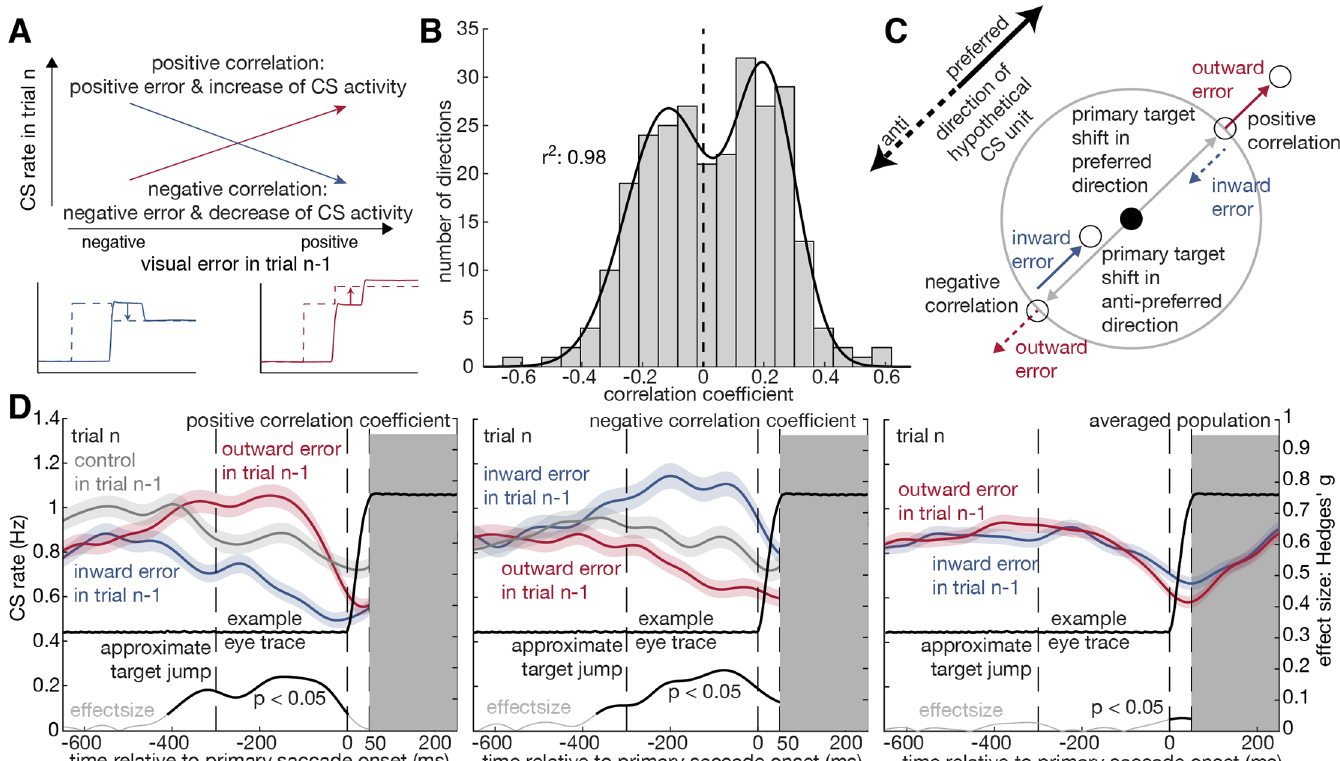
Fig 4. Correlation of visual error in trial n − 1 and CS activity in trial n . Correlation analysis of influence of the size of visual error in trial n − 1 on the average CS activity during the significant MI interval in interval II (the primary error period) of trial n . The correlation was carried out for all directions with significant MI. A Schematic graph explaining the emergence of positive and negative correlation coefficients between the secondary visual error in trial n − 1 and the CS activity in trial n . B The distribution of correlation coefficients obtained is bimodal and can be fitted by a sum of two Gaussians (r 2 = 0.98). C CS units whose preferred directions are aligned with the outward error will exhibit a positive correlation with the size of the outward error and a negative correlation with the size of the inward error, the latter assuming that the nonpreferred direction is opposite to the preferred direction (left). Conversely, CS units whose preferred directions are aligned with the inward error will exhibit the inverse behavior (right). The colored arrows indicate the direction of the error (and the corrective saccade), the solid black arrow the CS unit’s preferred direction, and the dashed black arrow its nonpreferred direction. D Blue, grey, and red curves show the average CS spike density functions ± SEM prior to primary saccade onset in trial n for the three different error conditions (outward, inward, no error = “control”) in trial n − 1. The curve on the bottom shows the Hedges’ g effect size in grey and indicates a significant ( t test, p = 0.05) difference between the red and the blue curve in black. The vertical dashed lines indicate from left to right the approximate time of the target jump, the start of the primary saccade as alignment point, and the approximate end of the primary saccade at 50 ms. The solid black curve in the center of each panel is an eye trace of a 10-degree saccade shown to facilitate relating the CS SDF to the time course of a saccade. For the rightmost panel, we skipped the averaged control condition to focus on the subtle difference between inward and outward error conditions. Note also that the control condition will be influenced by visual errors that might have prompted corrective saccades, as saccades amplitude vary across an ideal size and may even—depending on the individual— exhibit systematic deviations in the one or the other direction. Underlying data available from the Dryad Digital Repository: https://doi.org/10.5061/dryad.p88b8v8. CS, complex spikes; MI, mutual information; SDF, spike density function.